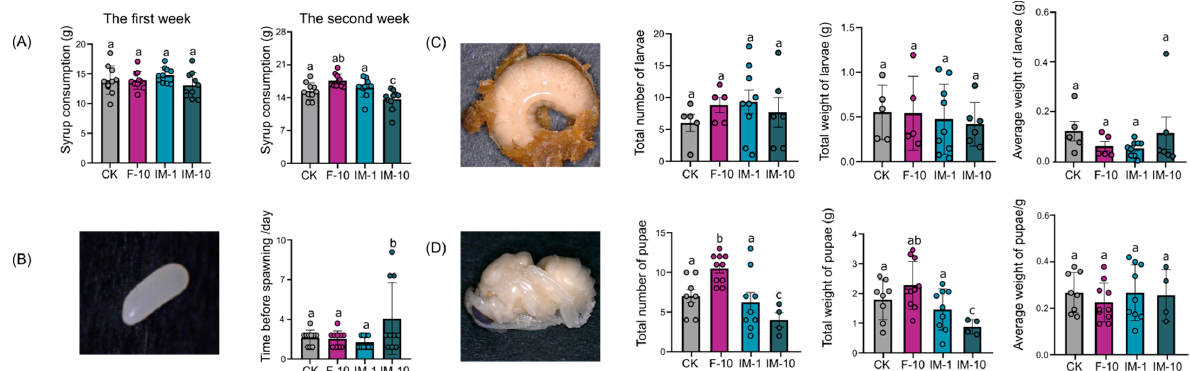
Figure 2. Effect of pesticide exposure on bumblebee larval and pupal development. ( A ) Syrup consumption in B. terrestris worker microcolonies ( n = 40) after two weeks of pesticide exposure treatments. ( B ) Time of first egg deposition in B. terrestris worker microcolonies. ( C ) The total number, total weight and average weight of larvae for different pesticide treatments. ( D ) The total number, total weight and average weight of pupae for different pesticide treatments. Significant differences between groups were determined by one-way ANOVA with Tukey’s multiple comparisons